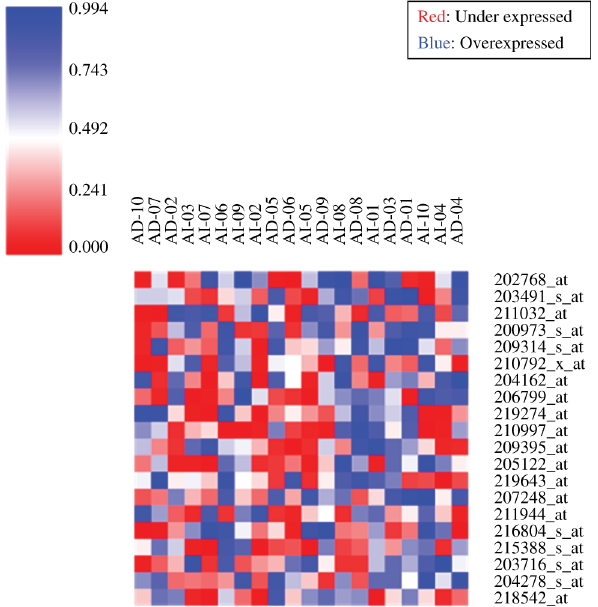
Figure 4: GeneMAD analysis for GSE2443 (20 samples), representative heatmap with red color showing under expressed probes and the blue ones being